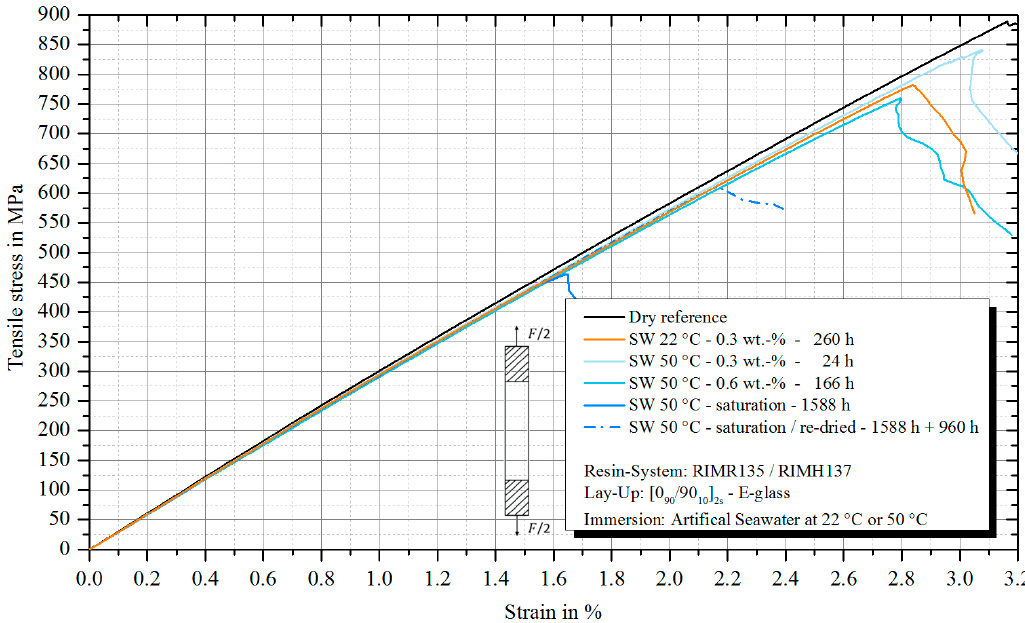
Figure 9. Stress–strain curves of representative tensile tests on dry reference and hygrothermally aged specimens. Strains were measured using an extensometer within the free gauge length.